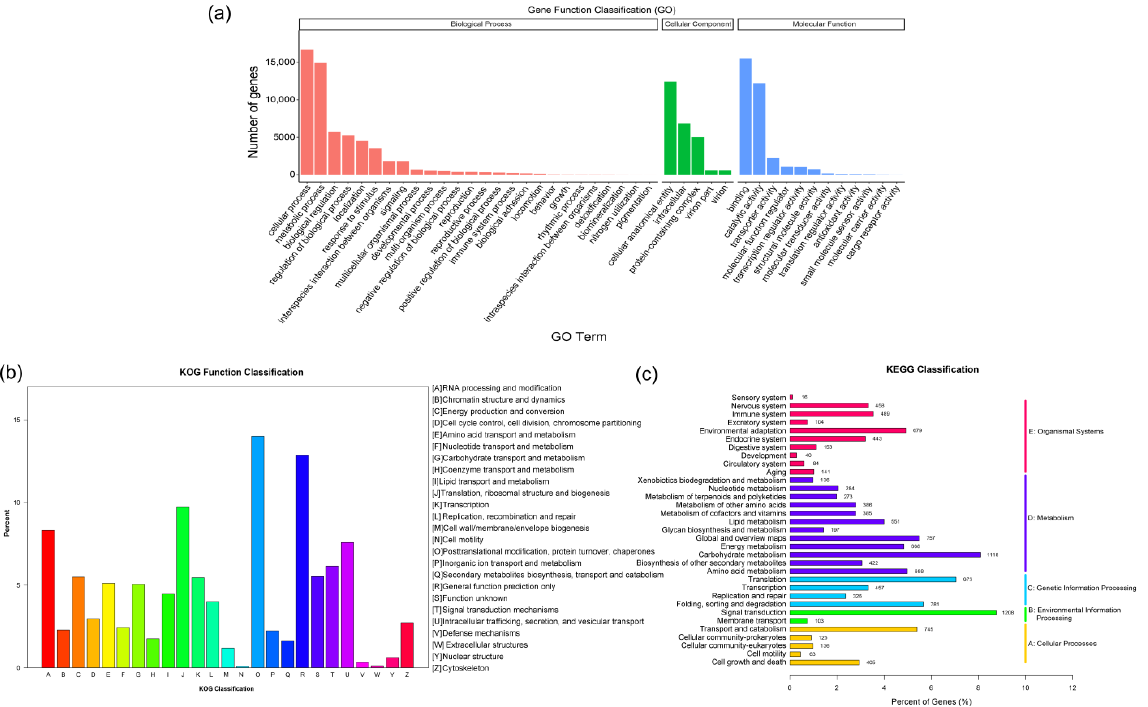
Figure 2. Gene Ontology (GO), KOG (euKaryotic Ortholog Groups) and KEGG (Kyoto Encyclopedia of Genes and Genomes) classification of Michelia macclurei unigenes.